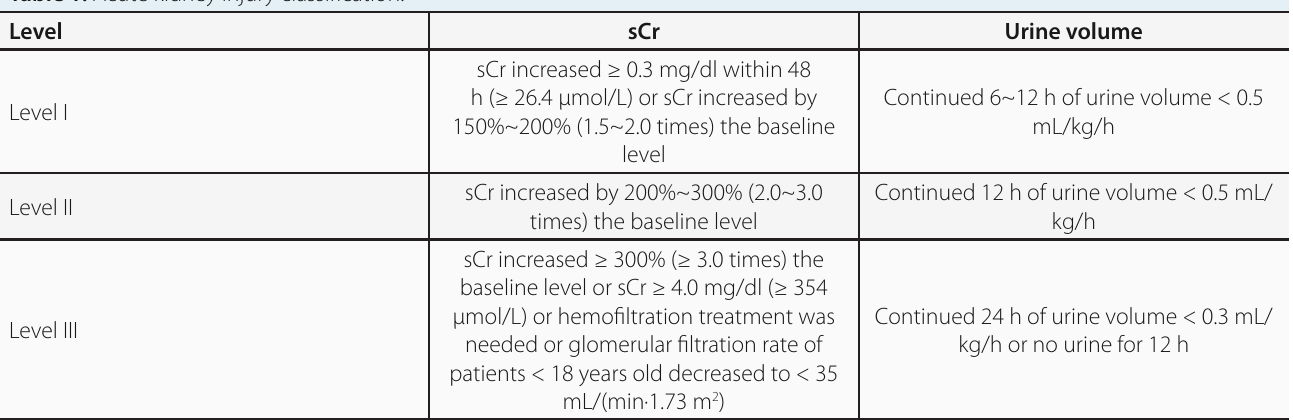
Table 1. Acute kidney injury